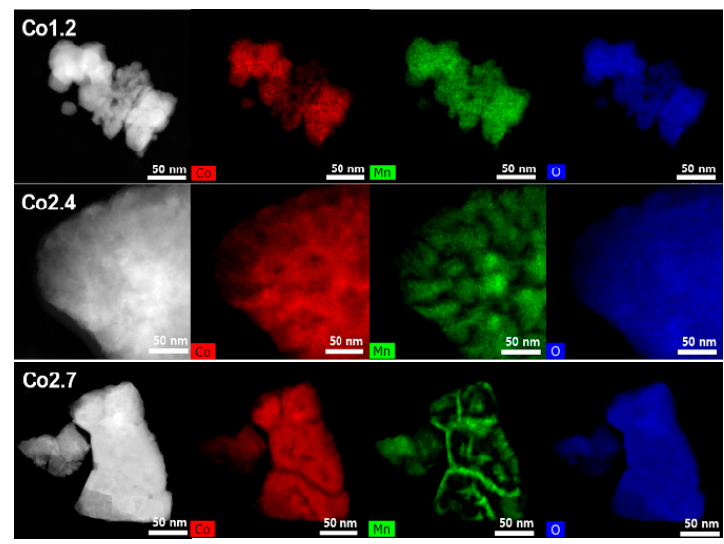
Figure 2. TEM-EDS mapping images for Co, Mn, and O in the mixed phases of Co- and Mn-based materials with Co = 1.2, 2.4, and 2.7.